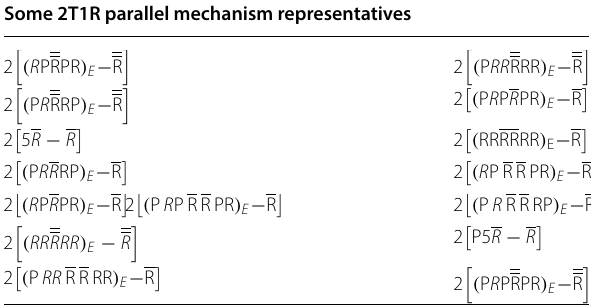
Table 9 Types of symmetric